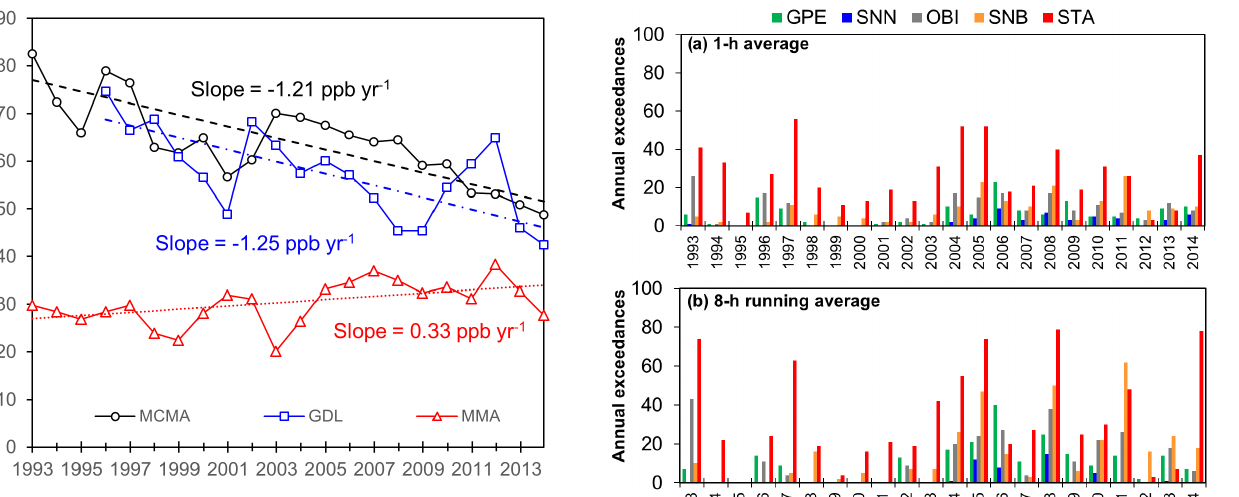
Figure 10. Trends in NO x in the MCMA and MMA during 1993– 2014 and in the GMA during 1996–2014. The dashed lines repre- sent the Sen slopes. All trends are statistically significant at p < 0 . 05.